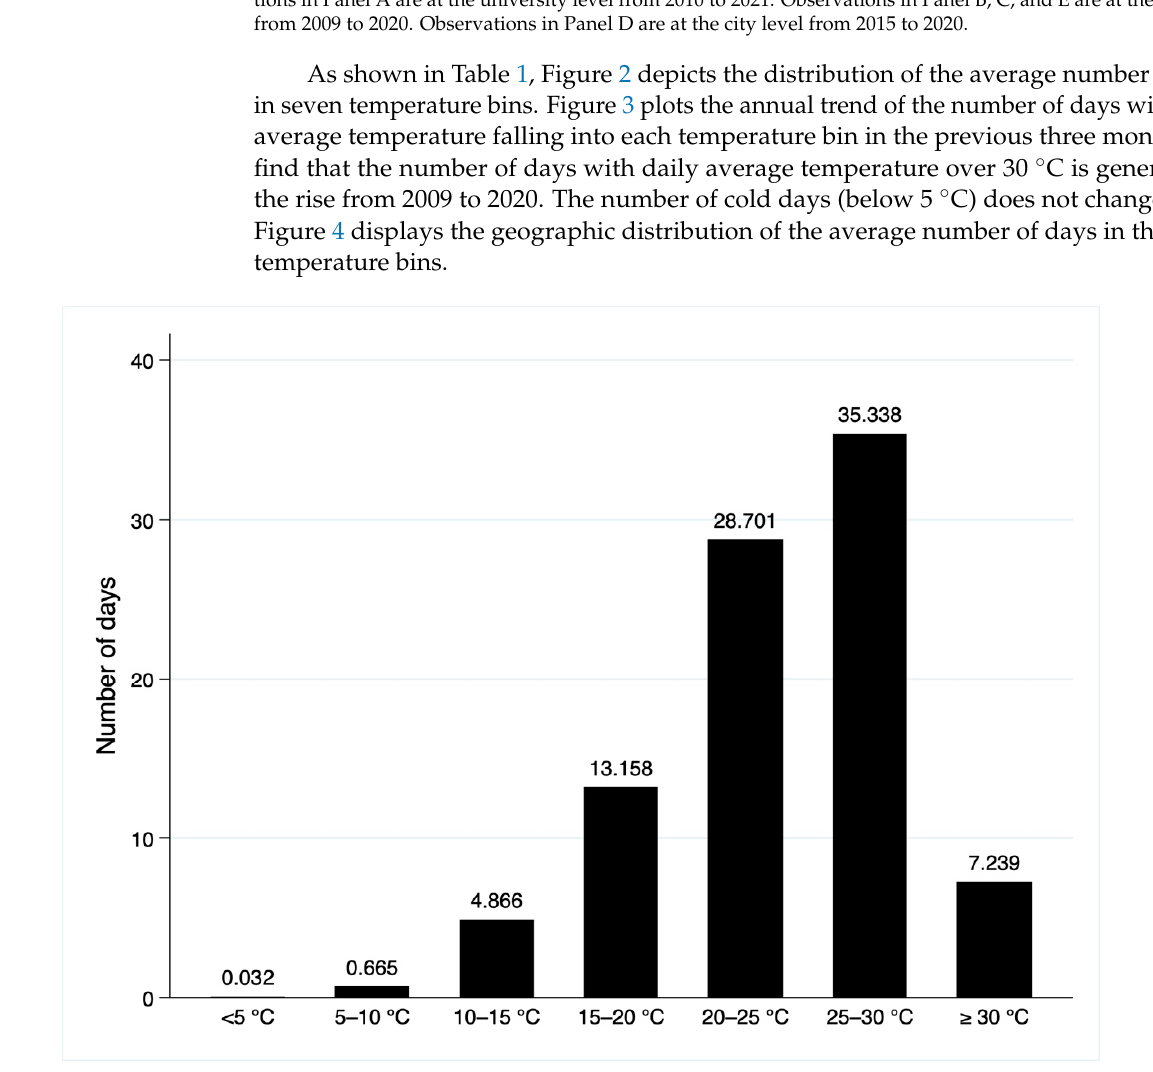
Figure 2. Distribution of daily average temperature in the previous three months in the estimation sample.